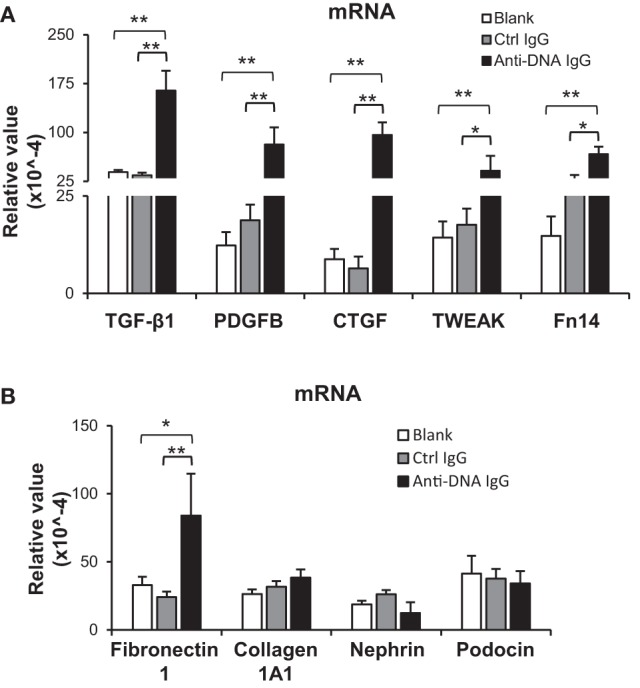
Evaluation of renal mRNA levels of profibrotic factors in SCID mice. Mice were intravenously injected with control or anti-dsDNA IgG before tissue collection. (A) The mRNA expression levels of profibrotic cytokines [transforming growth factor (TGF)-β1, platelet-derived growth factor subunit B (PDGFB), and connective tissue growth factor (CTGF)] and proinflammatory factors (TWEAK and Fn14) were determined in fresh kidney tissues. (B) The mRNA levels of extracellular matrix components (fibronectin 1 and collagen 1A1) as well as structural markers (nephrin and podocin) were determined similarly. There were no differences between the mice in blank and control IgG groups (p > 0.05). There were five mice in each group. Data points and error bars represent mean ± SEM (*p < 0.05, **p < 0.01).